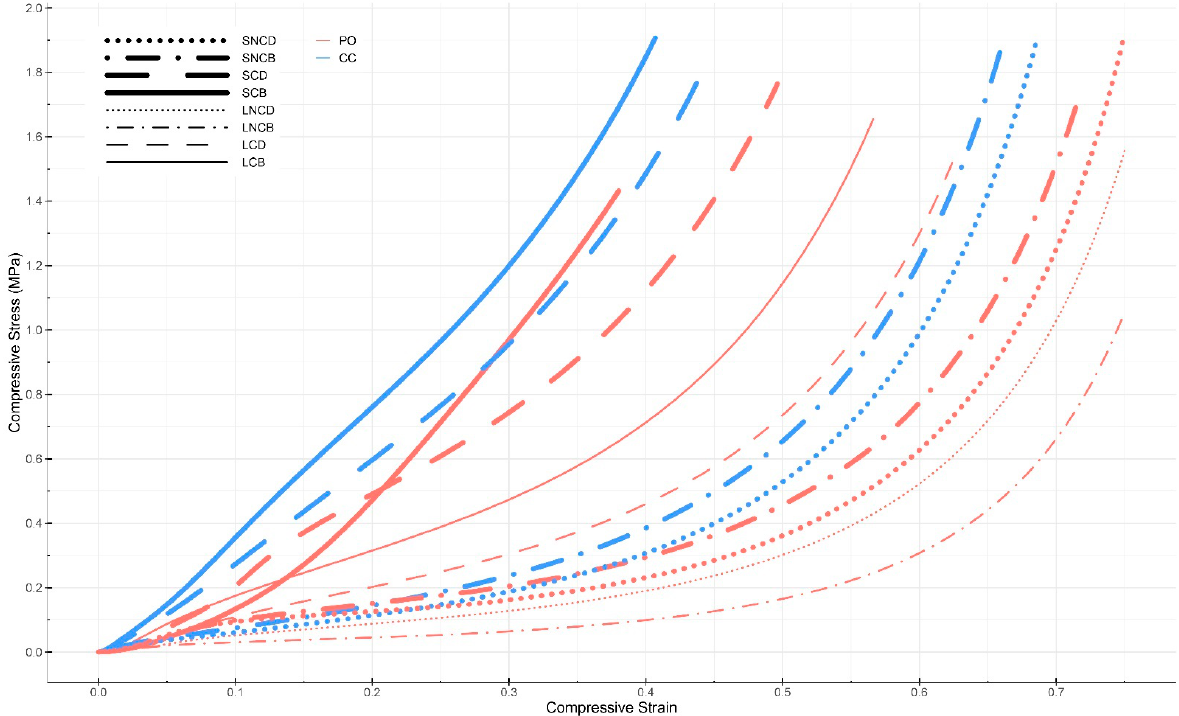
Figure 3. This figure shows the mean stress–strain curves for each sample of mycelium-based materials. The stress required to compress the material (i.e., increasing strain) increases linearly then exponentially. Due to the high variability in the stress–strain slope, the Young’s modulus was calculated from 3 different strains as shown in Table 2. The Young’s modulus used for comparison was calculated from 0.19 to 0.21 strain, to represent the slope of the stress/strain curve at 0.20 strain. “PO” stands for samples grown from Pleurotus ostreatus , and “CC” for Coprinus comatus . Acronyms for each sample are labeled in Table 1.